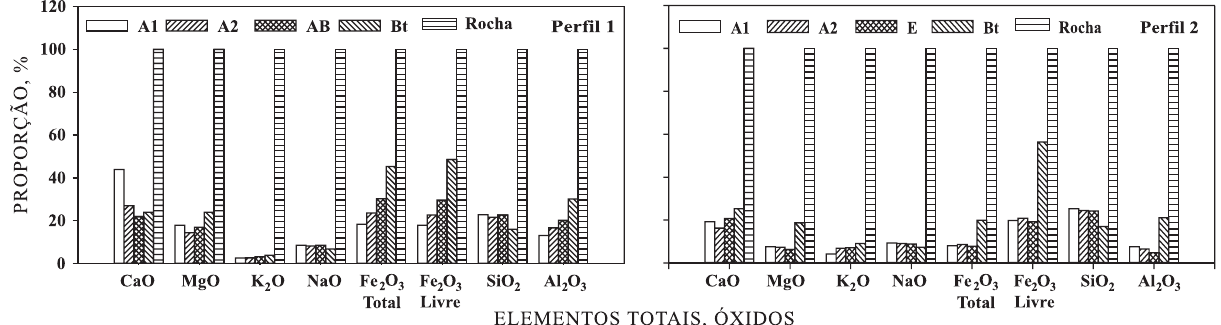
Figura 1. Proporção, em relação ao material de origem, de elementos totais presentes nos horizontes de um Argissolo Vermelho-Amarelo distrófico abrúptico, perfil 1, localizado em meia encosta sob campo nativo e perfil 2, em topo de coxilha sob vegetação